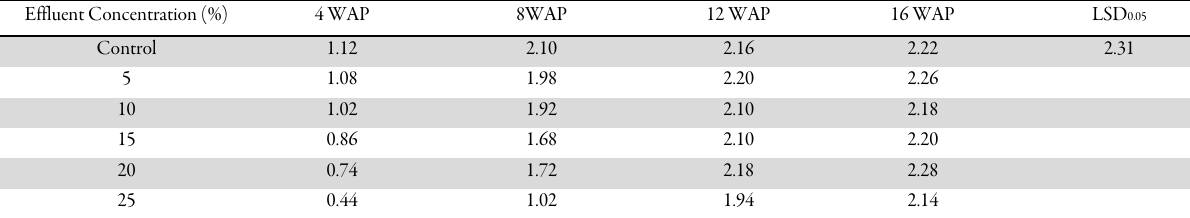
Table 2. Stem girth (cm) of Solanum lycopersicum treated with different concentrations of detergent effluent Effluent Concentration (%)